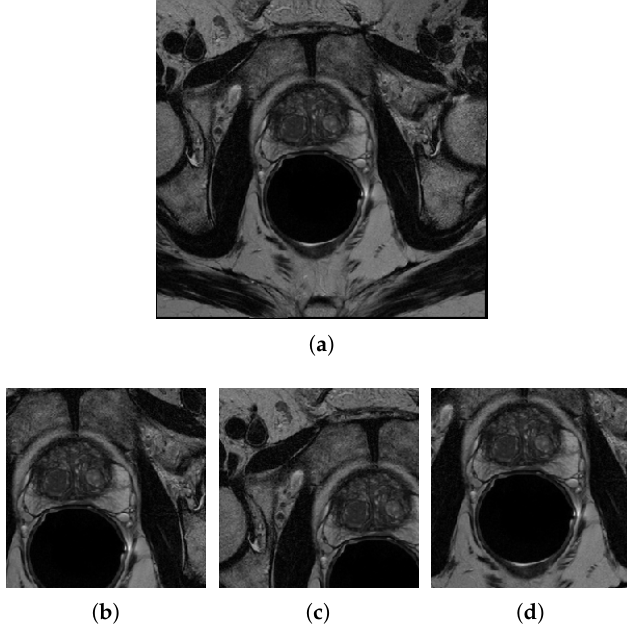
Figure 3. Sample of three (192 × 192)-pixel patches ( b–d ) generated from the (256 × 256)-pixel image in ( a